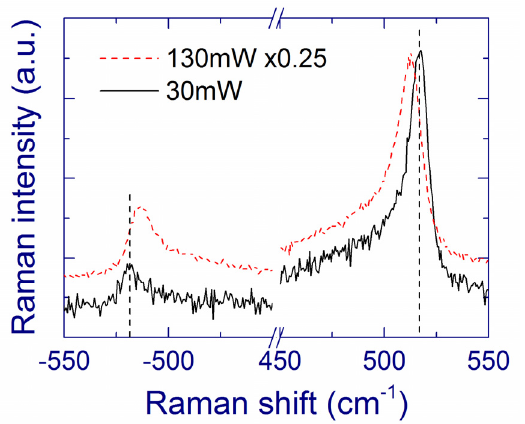
Figure 23. Raman spectra of a SiO 1.3 film on a silica substrate measured with two laser powers (~30 and ~130 mW focused to a ~40 μ m spot). The spectra are vertically shifted and scaled for better